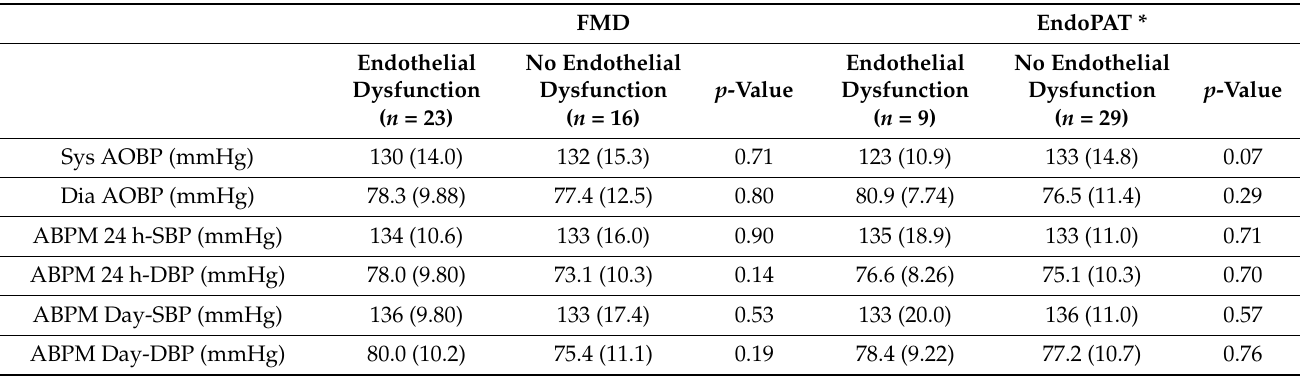
Figure 2. Platelet derived extracellular vesicles and retinal vascular density. Top panel. Schematic representation of the retina and the definitions for the zones employed in this study. The foveal density refers to the 1 mm diameter circle around the fovea, parafoveal to a ring from 1 mm to 3 mm around the fovea and whole image to everything within the 6 × 6 mm square centred on the fovea. Centre panel. Scatterplot of extracellular vesicles and superficial vascular plexus density at ( A ) fovea zone ( p = 0.74), ( B ) parafovea zone ( p = 0.58), and ( C ) whole image ( p = 0.66). Bottom panel. Scatterplot of extracellular vesicles and deep vascular plexus density at ( D ) fovea zone ( p = 0.67), ( E ) parafovea zone ( p = 0.86), and ( F ) whole image ( p = 0.89). Blue line represents the regression line of best fit. The grey bands around the line represents 95% confidence intervals. Table 3. Summary of the platelet derived extracellular vesicles and blood pressure measurements in patients with and without endothelial